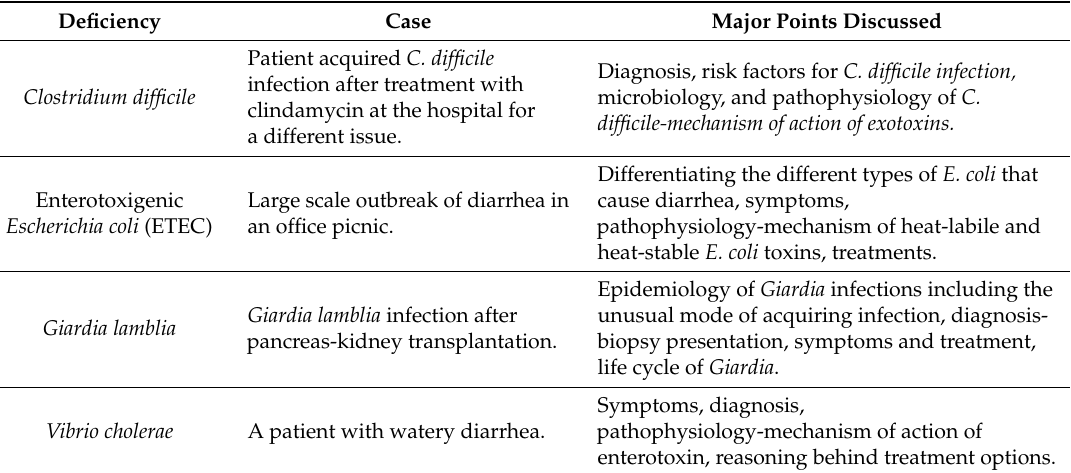
Table 2. Highlights of the infectious diarrhea cases used in the session.